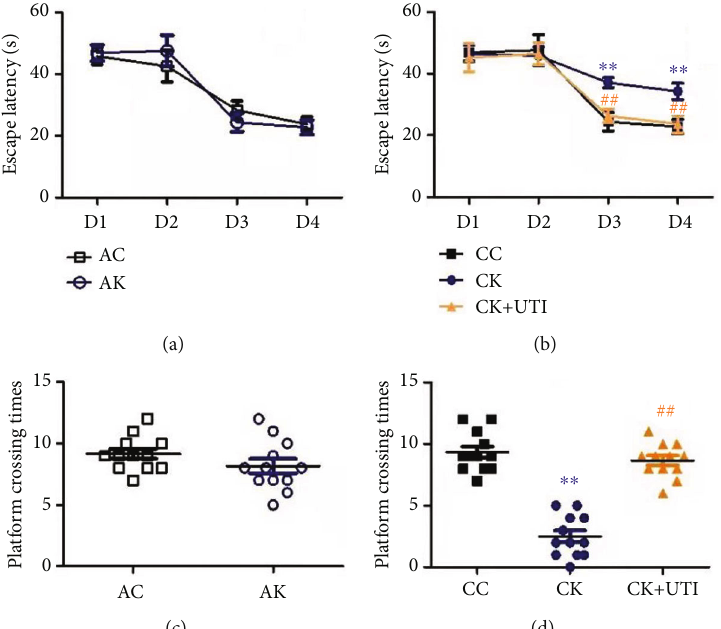
Figure 2: Repetitive KET-induced learning and memory impairment. (a) and (b) demonstrated the sailing time; (c) and (d) showed the platform-crossing times. All consequences were expressed as mean ± SD ( n = 12 ). ∗∗ P < 0 : 01 , and ## P < 0 : 01